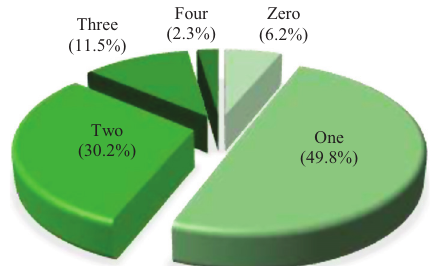
Figure 3. Recycling scores